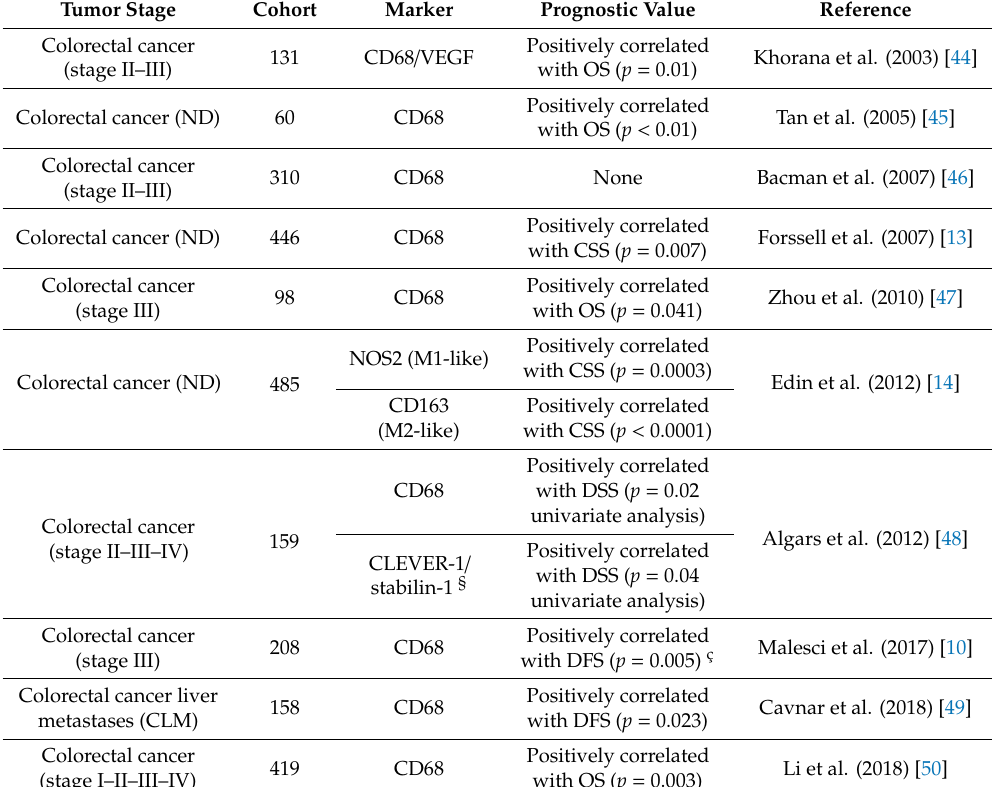
Table1. Tumor-associatedmacrophageinfiltrationasapredictorofpatientoutcomesincolorectalcancer.